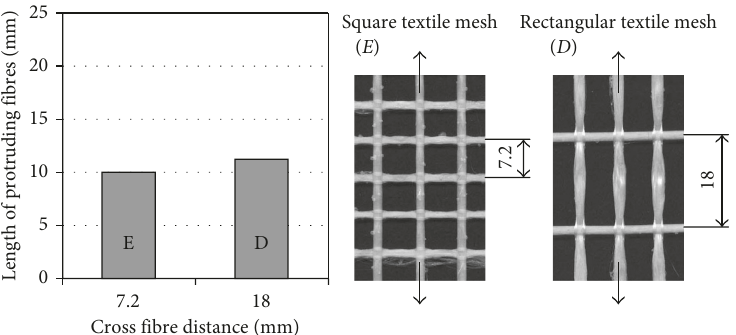
Figure 11: Effect of the cross fibre distance of coated textiles on the textile’s development